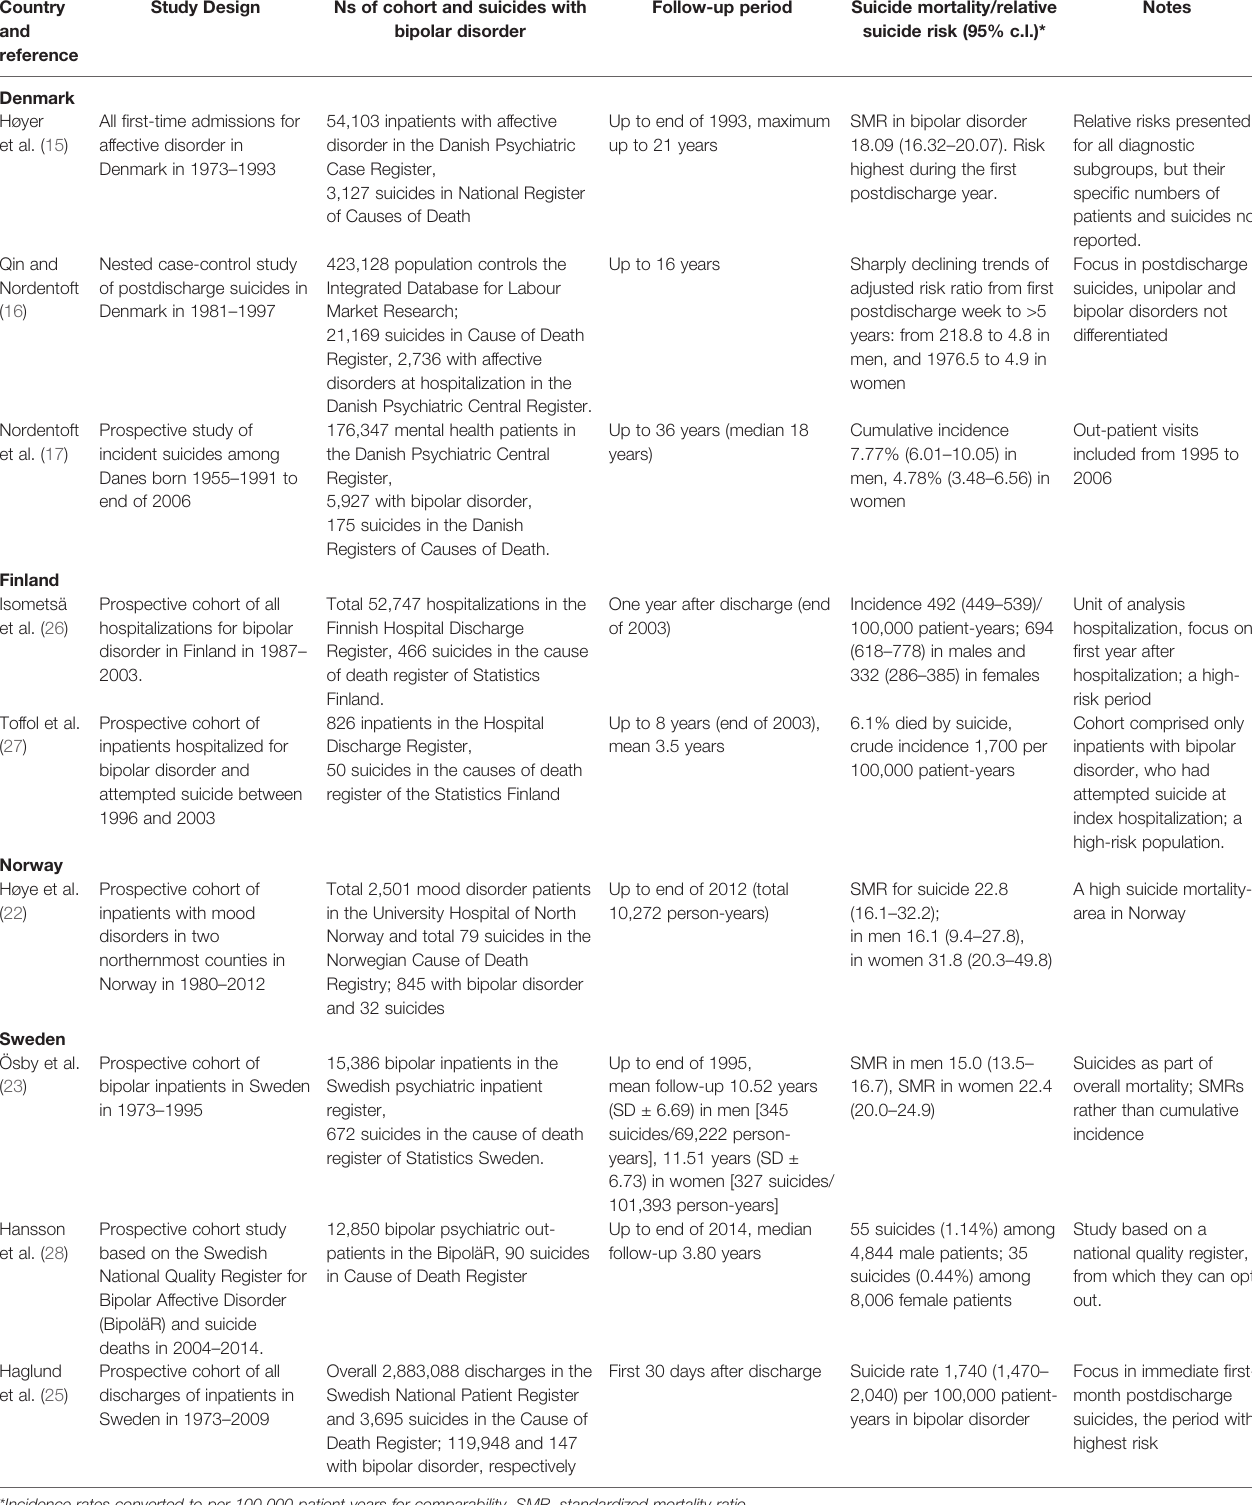
TABLE 2 | Suicide mortality in bipolar disorder in Nordic national-level register-based